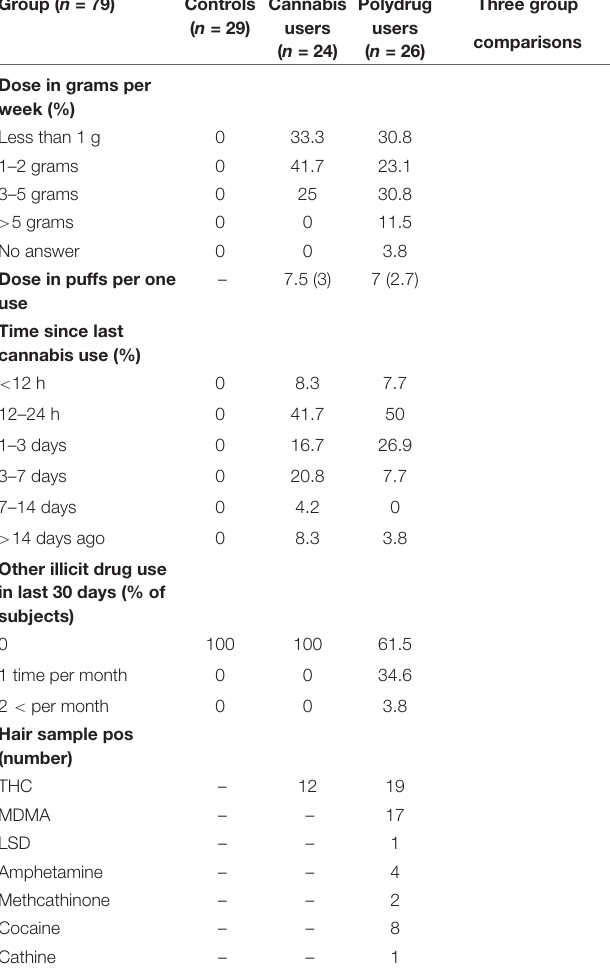
TABLE 1 | Demographic, neuropsychological and substance use characteristics for participants included in behavioral